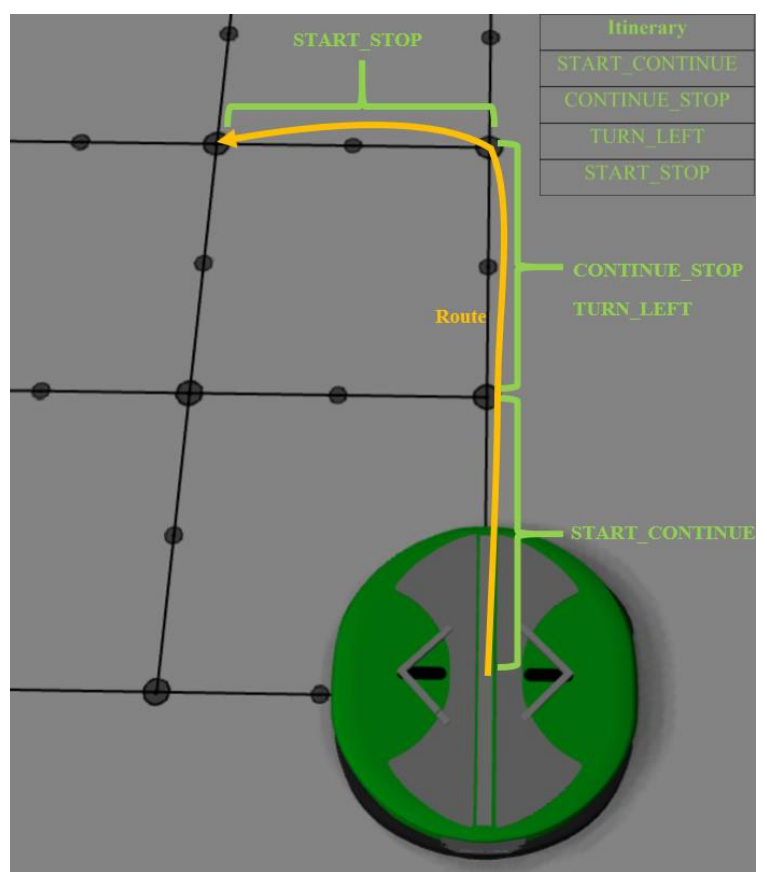
Figure 9. An example itinerary.